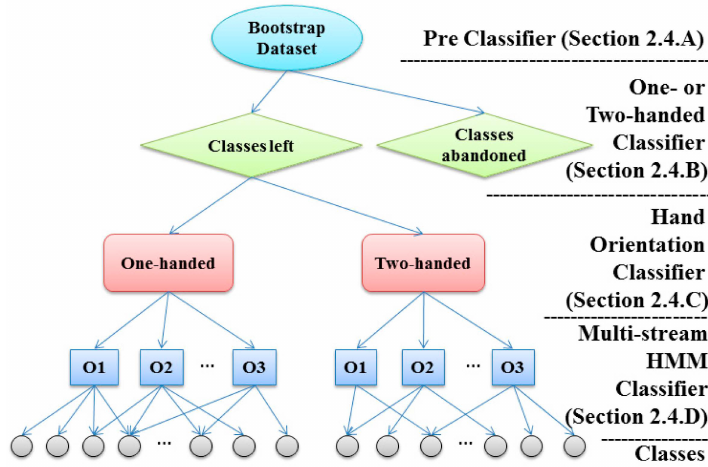
Figure 5. Structure of the improved decision tree in random